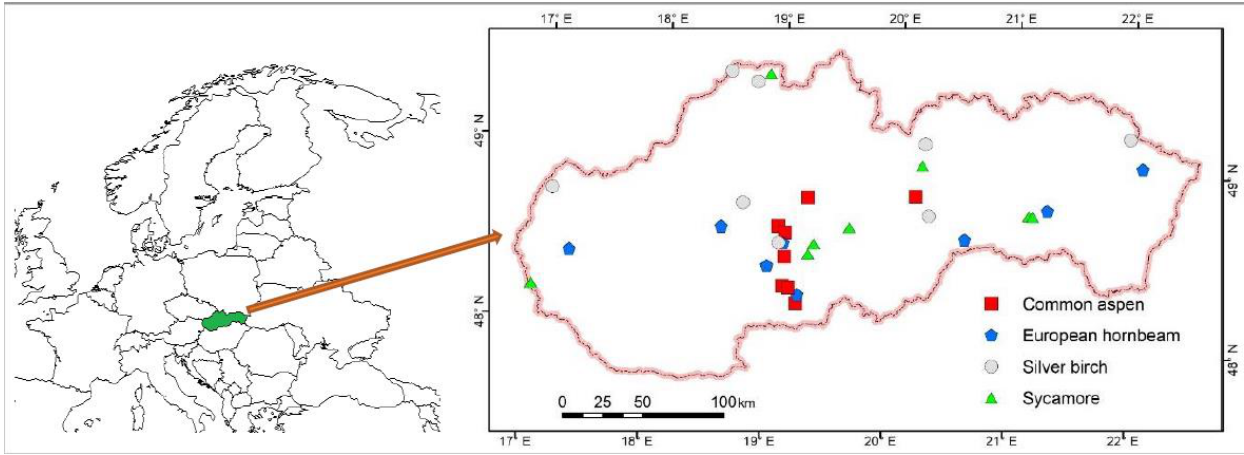
Figure 7. Location of plots used for sampling biomass of four broadleaved tree species in the area of Slovakia.